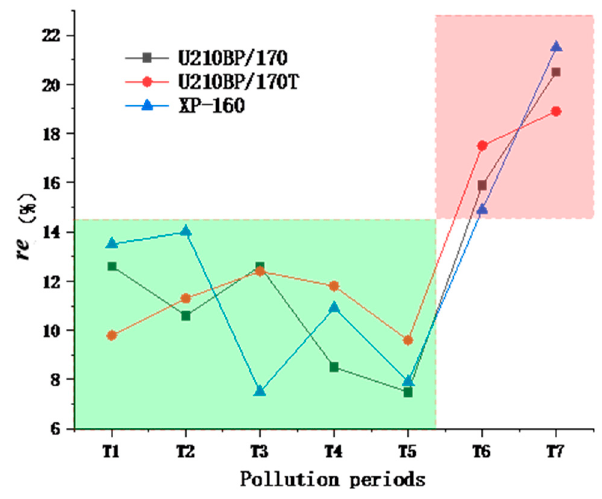
Figure 8. Calculated re.